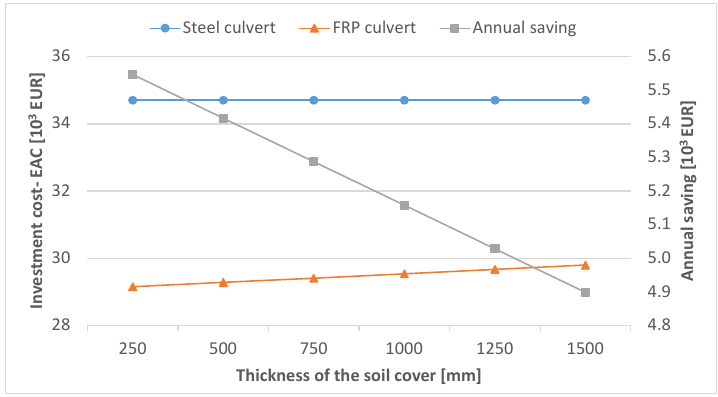
Figure 19. Impact of reduced soil cover thickness on the investment cost and annual saving.